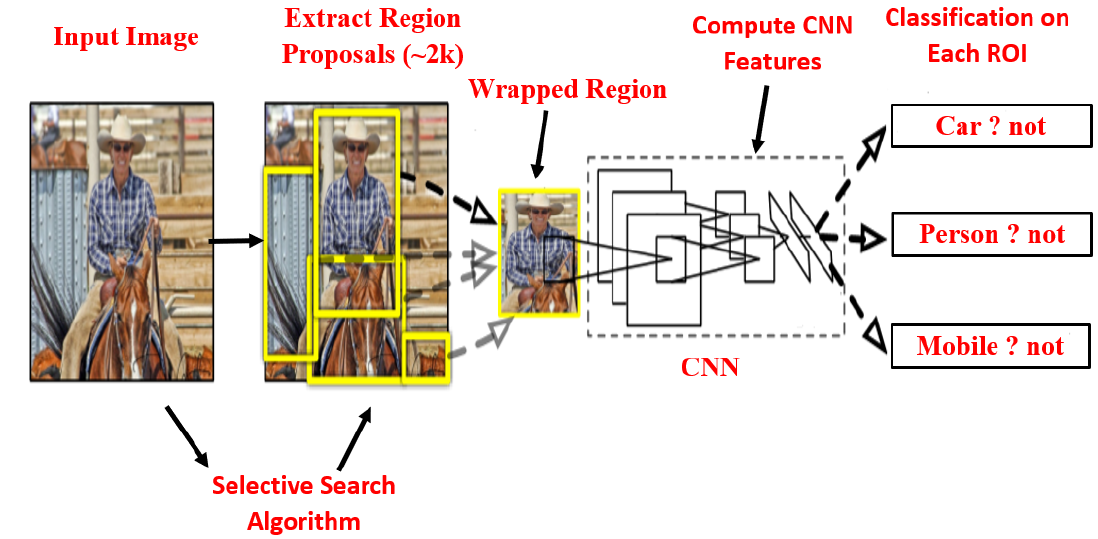
Figure 4. RCNN architecture